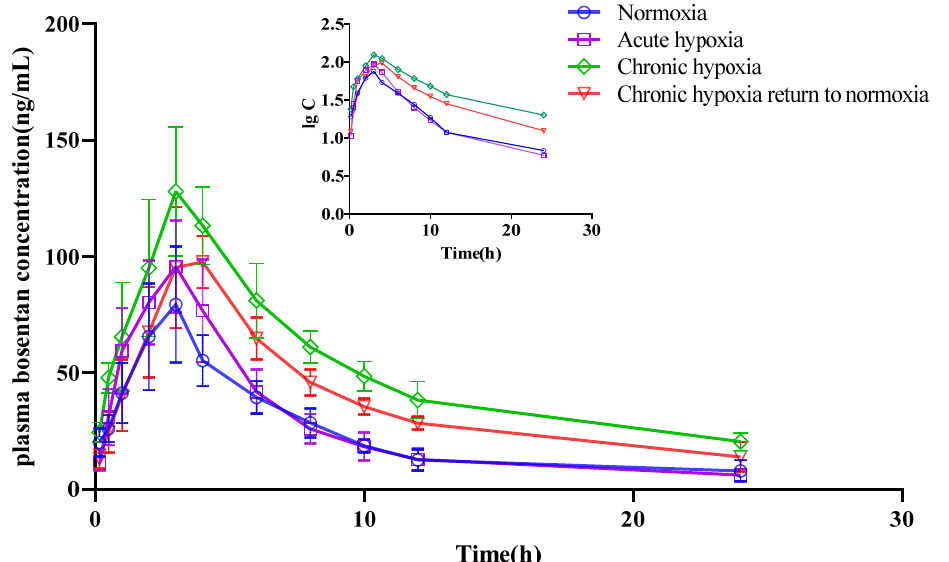
Figure 10. Mean plasma concentration time curve of bosentan for rats after exposure to high-altitude hypoxia ( n = 8).